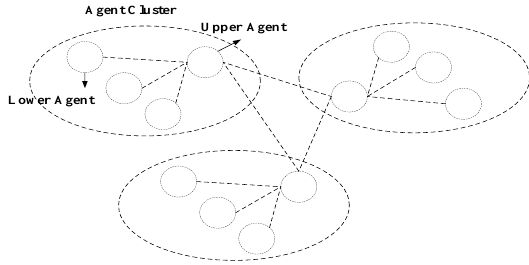
Figure 2. Hybrid multi-agent architecture.